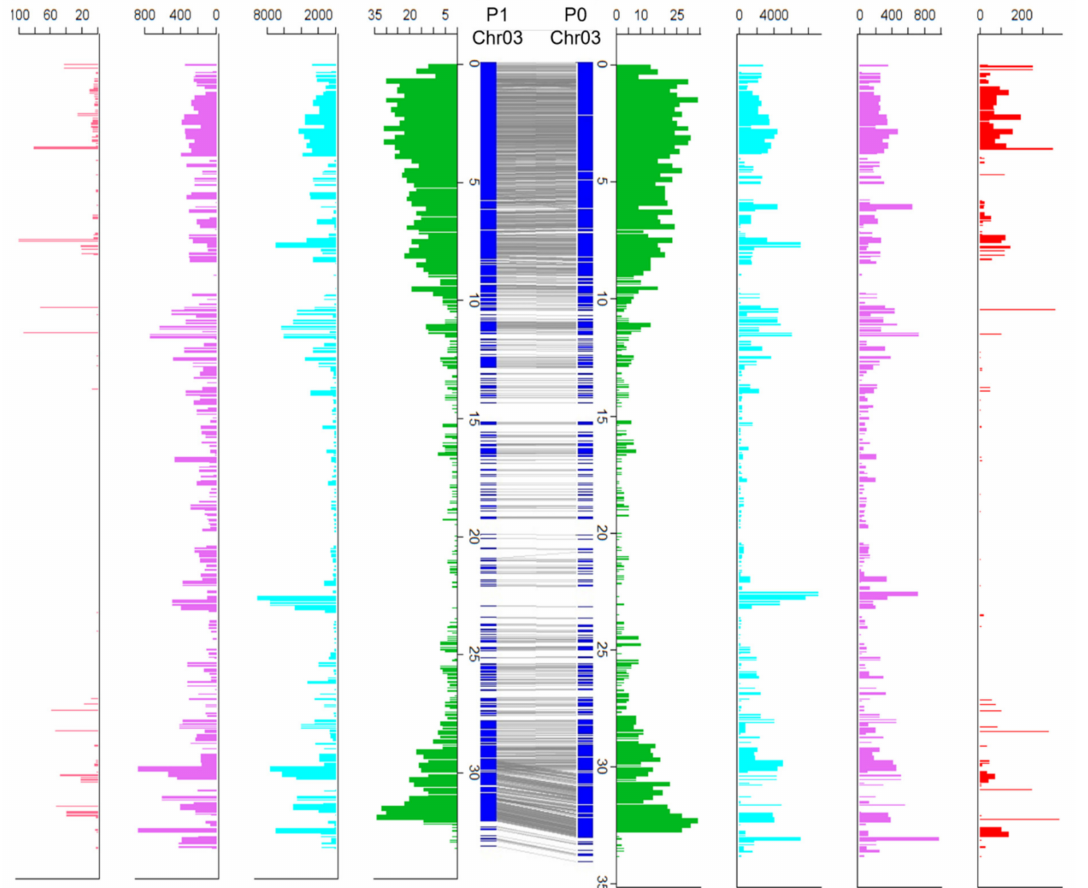
Figure 3. Haplotype diversity in the MD2 chromosome 3. The central blue bars represent the two haplotypes of chromosome 3. The gray lines indicate collinear genes. Outer plots include: distribution of genes (green), SNP density (cyan), INDEL density (pink), and density of potential deleterious effect variants (red). All numbers were determined in 200 kb